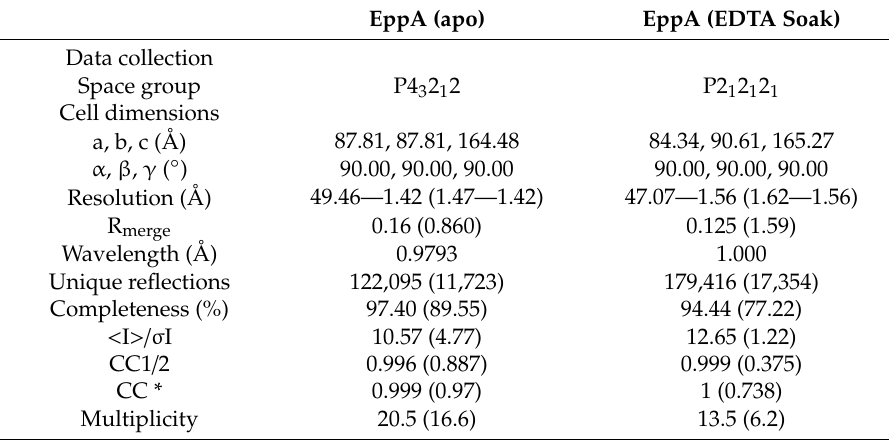
Table 5. X-ray di ff raction data collection and structure refinement